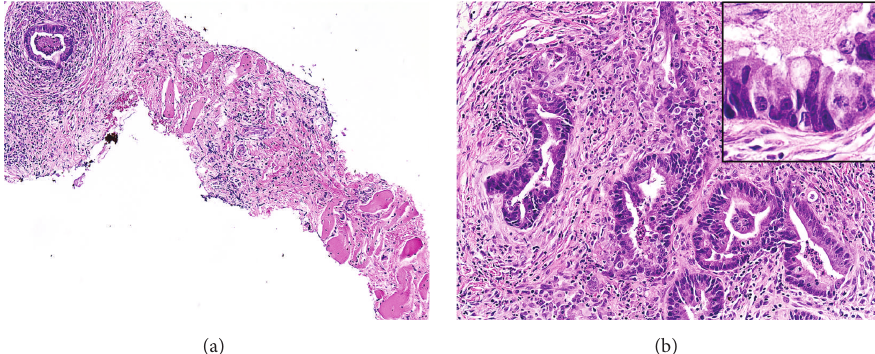
Figure 3: Histologic sections of the biopsy. (a) Malignant glands are seen infiltrating through skeletal muscle (hematoxylin/eosin, × 100). (b) The glands are lined by columnar cells with intestinal epithelial morphology and contain necrotic debris in the lumina (hematoxylin and eosin, × 200); occasional goblet cells are also present ( inset , hematoxylin and eosin × 600).